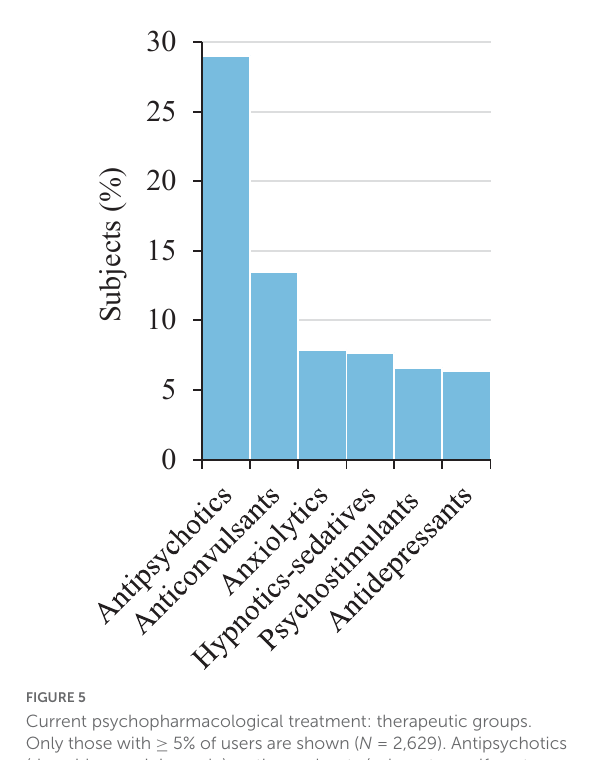
FIGURE5 Current psychopharmacological treatment: therapeutic groups. Only those with ≥ 5% of users are shown ( N = 2,629). Antipsychotics (risperidone, aripiprazole), anticonvulsants (valproates, sulfamates, carboxamides), anxiolytics (benzodiazepines), hypnotic-sedatives (melatonin), psychostimulants (methylphenidate), and antidepressants (SSRIs). Only those with ≥ 1% of users are shown ( N = 2,629). SSRIs, selective serotonin reuptake